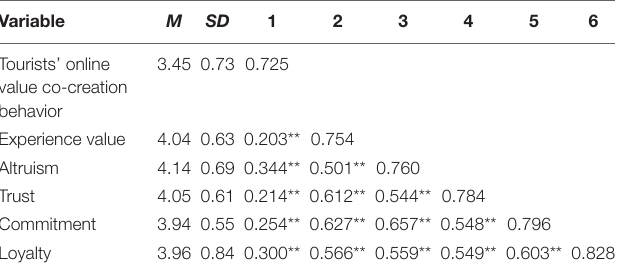
TABLE 4 | Decribes the results of statistics and correlation analysis.